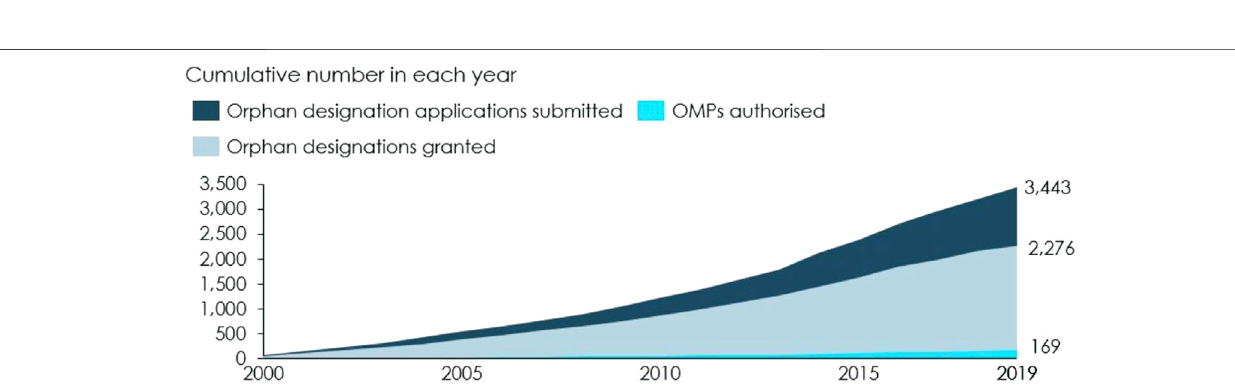
Frontiers in Pharmacology |